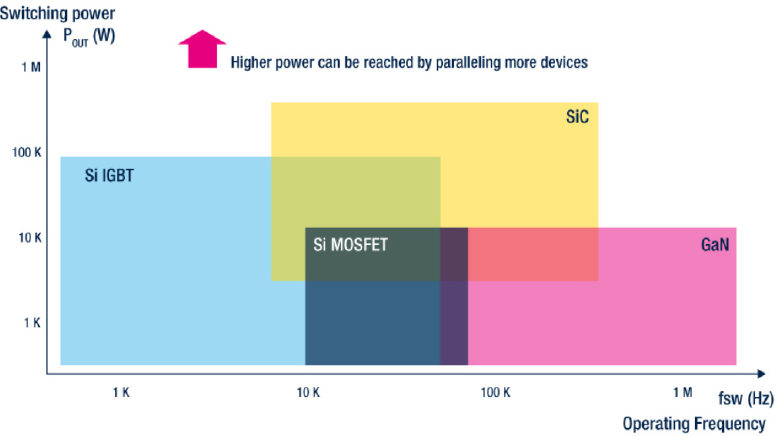
Figure 2. Application framework, based on output power and operating frequency, for Si-based IGBTs and MOSFETs, and SiC- and GaN-based power devices. Image from [23].